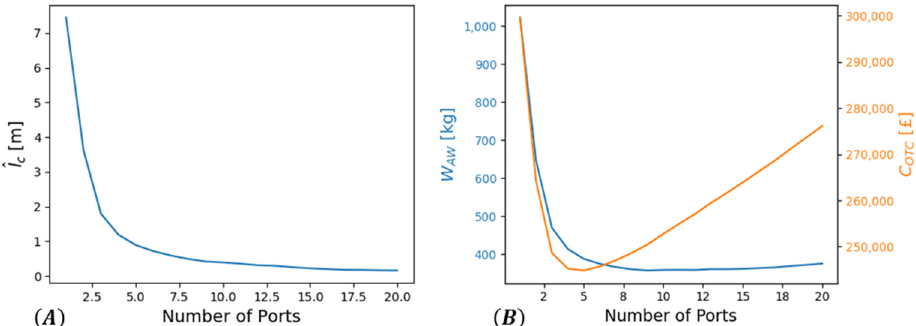
Figure 6. ( A ) Variation of ˆ l c and ( B ) W AW and C OTC with respect to the number of connection ports installed.